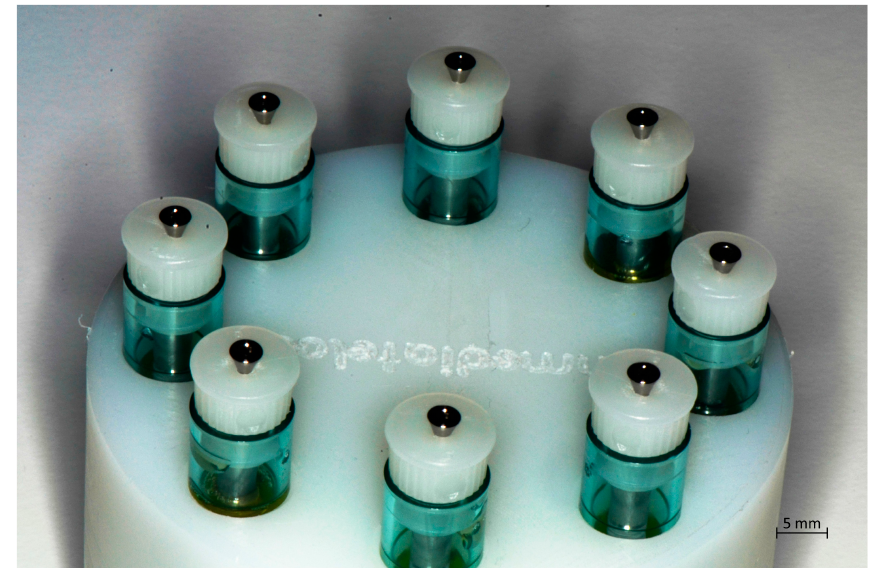
Figure 2. Centrifugation of the test tubes with Immediateload implants along with CGF or the Liquid Phase of CGF (LPCGF) by Round Up (Silfradent srl, Forlì, Italy).